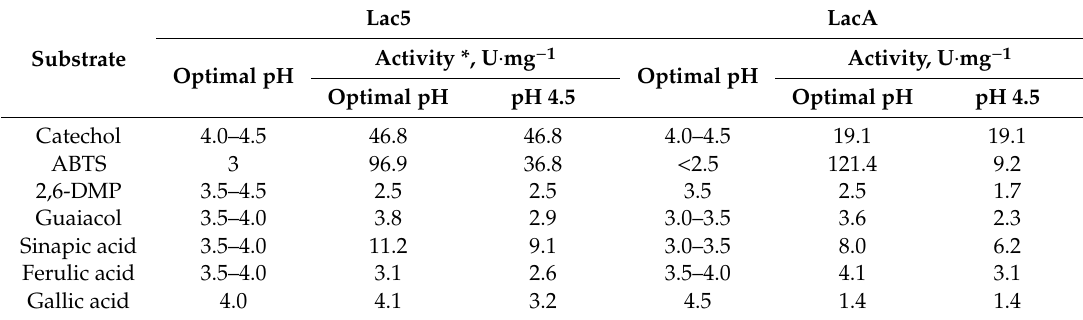
Table 1. The optimal pH values and catalytic activities of the obtained